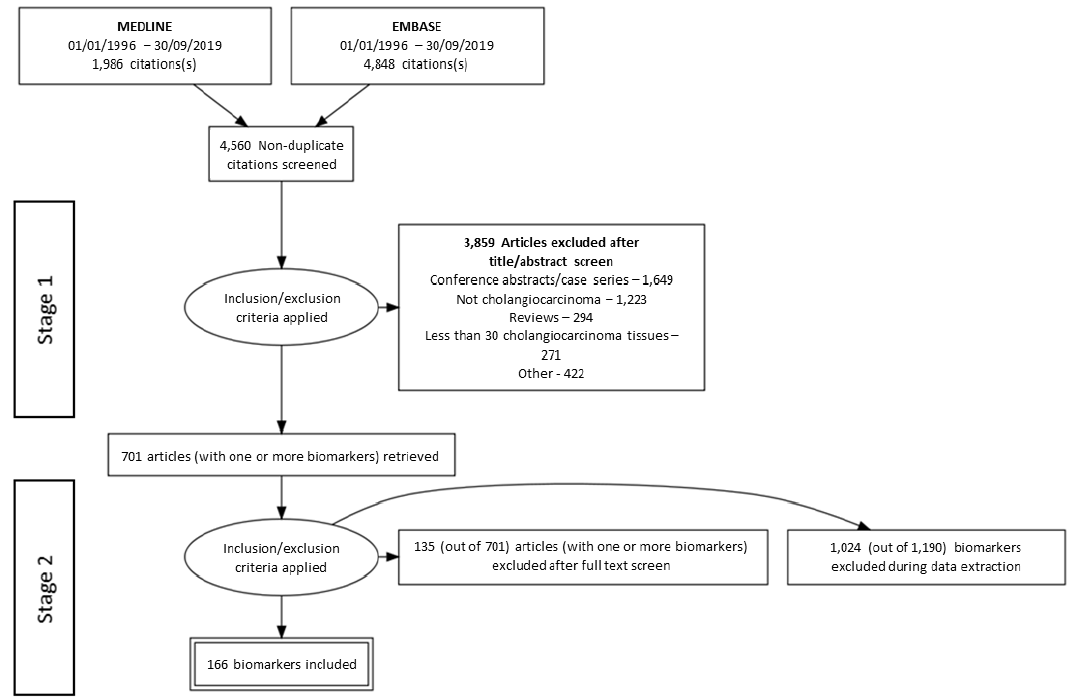
Figure 1. A flow diagram according to the Preferred Reporting Items for Systematic Reviews and Meta-Analyses (PRISMA) that maps the phases of the study selection process along with the number of records identified, excluded studies and/or biomarkers (and the reasons for exclusion), and biomarkers ultimately included in the systematic review.